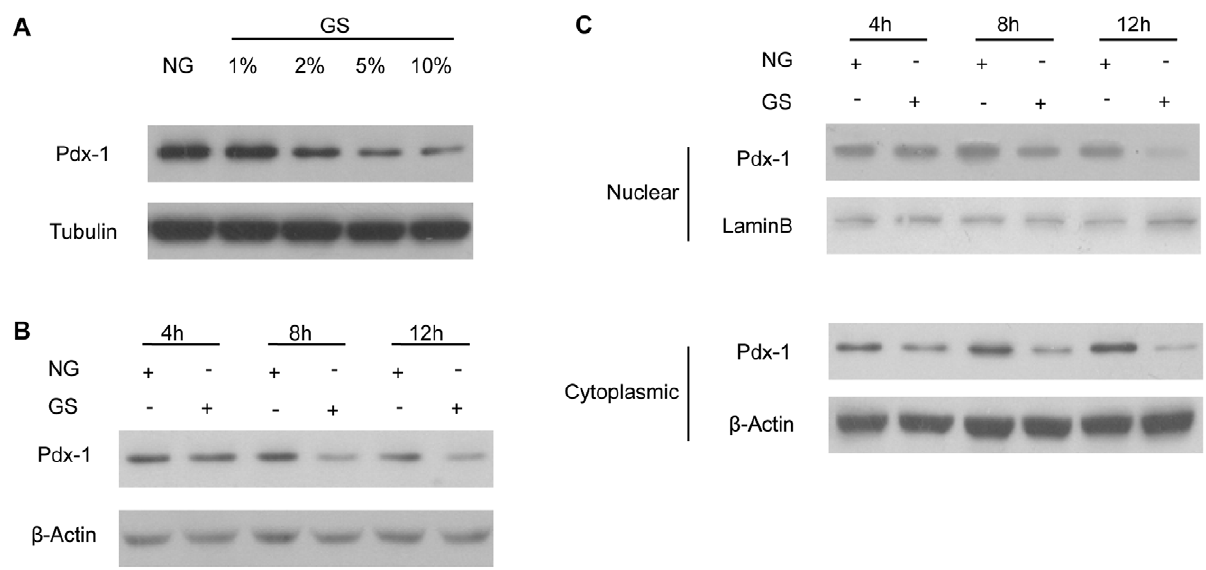
Figure 2. Glycated serum (GS) inhibited Pdx-1 protein expression. (A) INS-1 cells were treated with nonglycated (NG; control) serum or with varying concentrations of GS for 24 h and then harvested for western blot analysis. (B) INS-1 cells were treated with NG or 10% GS and harvested at the indicated time point for western blot analysis. (C) INS-1 cells were treated with NG or 10% GS for 4, 8, or 12 h. Cytoplasmic and nuclear protein was extracted, and then Pdx-1 determination was conducted.